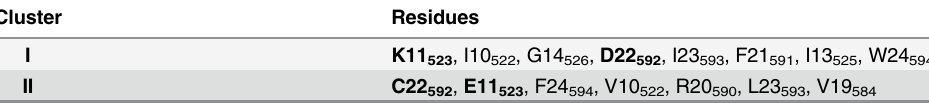
Listed in decreasing order of partial MI value. Residues in bold correspond to known SDPs. Subscripted positions correspond to those in PDB structure